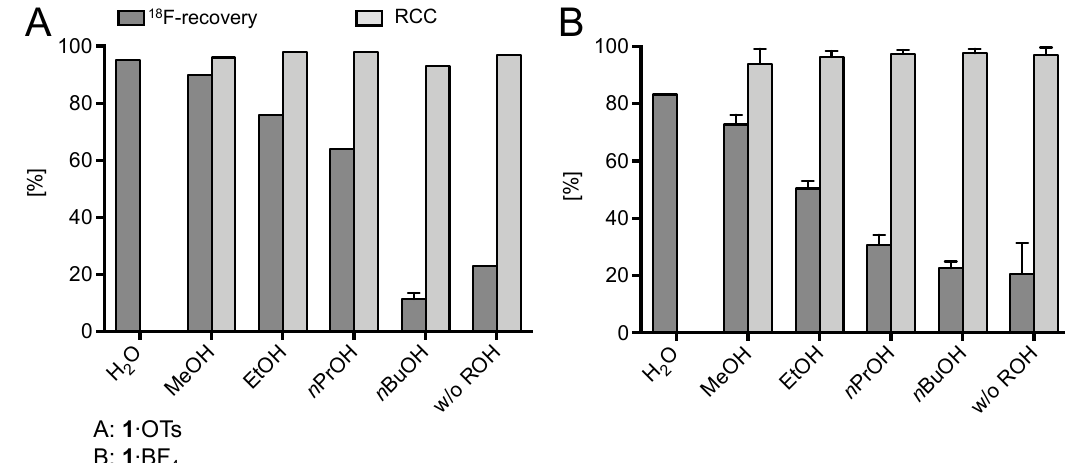
Figure 1. 18 F-Recovery and 18 F-incorporation (RCC) using di ff erent alcohols as co-solvents. Conditions: [ 18 F]Fluoride (50–200 MBq) was loaded on a QMA-CO 3 cartridge (not conditioned) from the male side and the cartridge was rinsed with MeOH (5 mL) in the same direction. Afterwards, [ 18 F]fluoride was eluted with a solution of 1 · OTs or 1 · BF 4 (21 µ mol) in ROH / DMF (120 / 500 µ L; 20% ROH) from the female side directly into a solution of Cu(MeCN) 4 OTf (7.9 mg, 21 µ mol) in DMF (600 µ L) and the resulting solution was heated at 85 ◦ C for 20 min. The reaction mixture was diluted with H 2 O (2 mL) and RCCs were determined by TLC (for 1 · OTs; experiments were carried out in Jülich) or HPLC (for 1 · BF 4 ; experiments were carried out in Saint-Petersburg). Experiments with 1 · OTs were carried out once (except for MeOH, n > 20 and n BuOH, n = 2) and with 1 · BF 4 in triplicate. Error bars represent standard deviations (SDs). Experiments with 1 · OTs were carried out in the self-made semi-automated synthesis module (Saint-Petersburg) and with 1 · BF 4 manually (in Jülich).